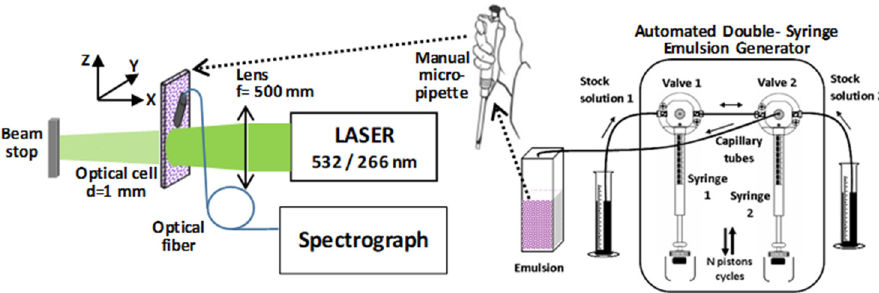
Figure 10. Scheme of the laser-assisted device that consist of an automated double-syringe emulsion generator unit and a laser emulsion processing unit.